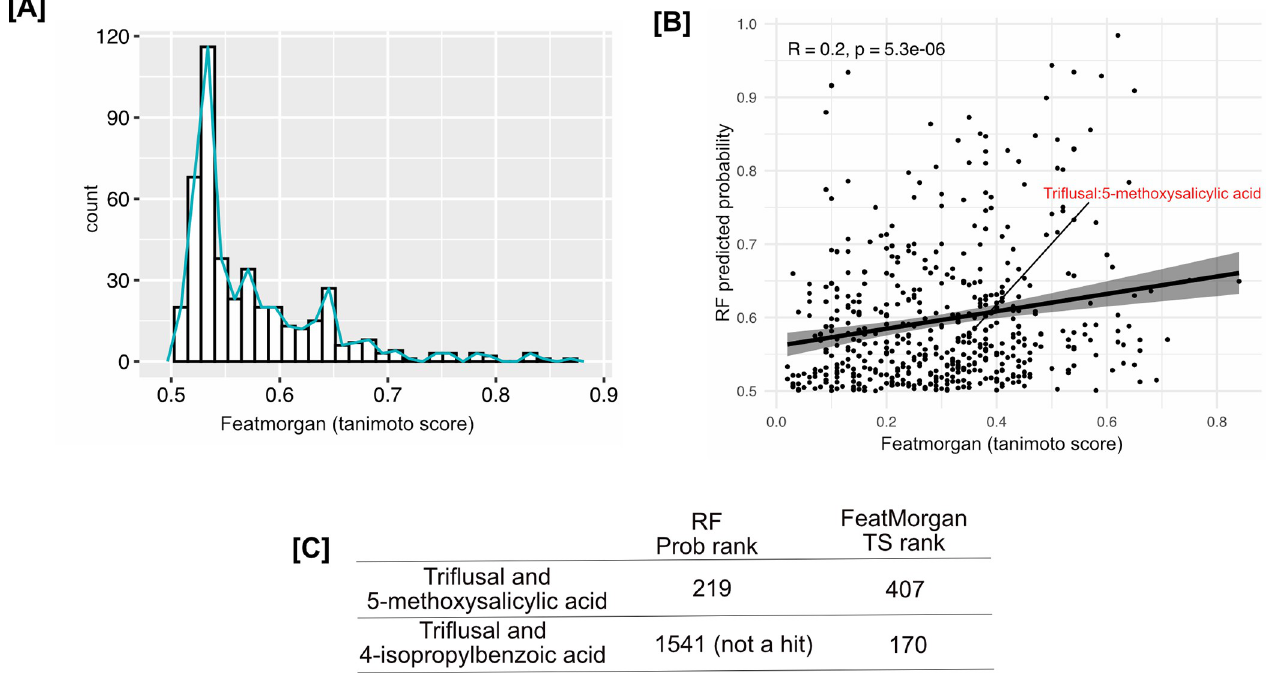
Fig 4. RF vs featmorgan. (A) Number of hits retrieved by using tanimoto score with featmorgan as similarity measure, which grows markedly as threshold is reduced (lower threshold means less similarity). (B) correlation between RF models’ average probability predictions > 0.5 with corresponding tanimoto score of featmorgan of drug-food pairs. Our hit pair triflusal and 5-methoxysalicylic acid (highlighted in red) was predicted a hit by RF models (as top 219 th pair) would be missed by featmorgan if used alone. (C) Rank comparison between hit pair (Triflusal:5-methoxysalicylic acid) and the negative control (Triflusal:4-isopropylbenzoic acid). The negative control was not a hit using RF models although had a higher rank with featmorgan than the hit pair and vice versa.